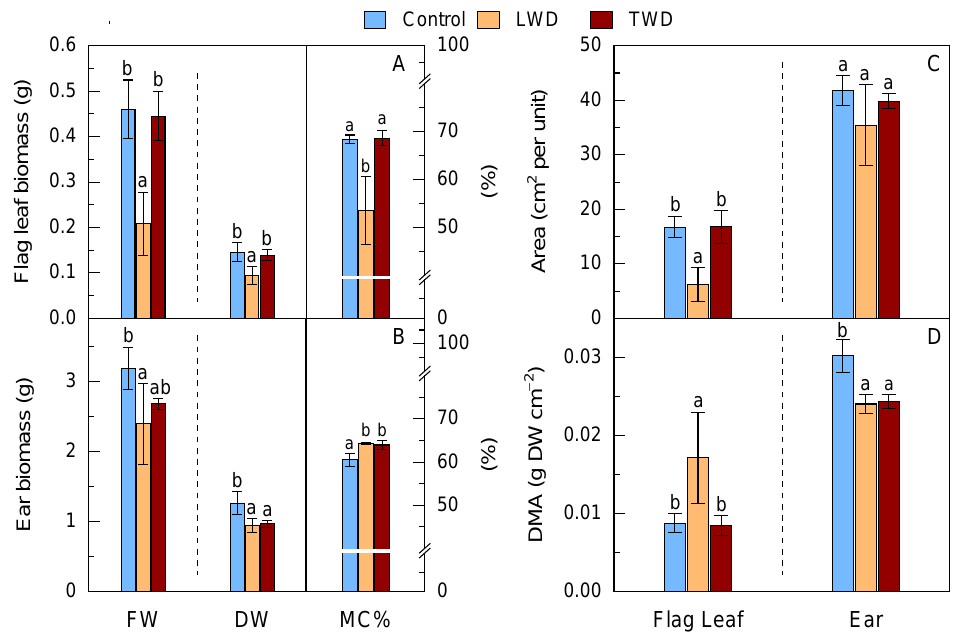
Figure 2. Effect of two water deficit treatments under combined elevated CO 2 and high temperature on the fresh weight (FW), dry weight (DW) biomass and moisture content percentage (MC%) of flag leaf (Panel A ) and ear (Panel B ), green area per organ unit (Panel C ) and dry matter per unit of area (DMA) (Panel D ) of potted wheat plants. Means of data from control (blue bars), long water deficit (LWD, orange bars) and terminal water deficit (TWD, dark red bars) are plotted together with the standard deviation (SD). Different letters above the bars (a and b) indicate statistically significant differences among treatments for each organ after post-hoc test analyses ( p -value ≤ 0.05, n = 4, see Spreadsheet S1,